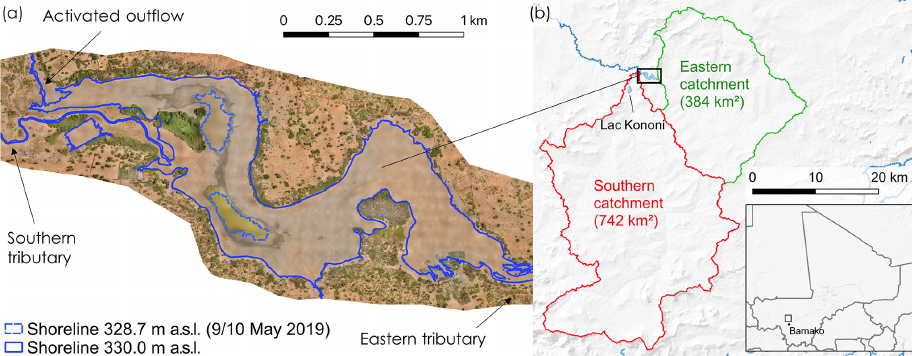
Figure 1. Overview map of Lac Wégnia. (a) Orthoimage mosaic from the UAV on 9–10 May 2019. The waterline at level 330ma.s.l. (based on the UAV-DEM) and on the days of the UAV flights (328.7ma.s.l.) is shown. The outflow is activated if the water level reaches above 329.8ma.s.l. (b) Outline of the two main contributing catchments and locations of Lac Wégnia and Lac Kononi in